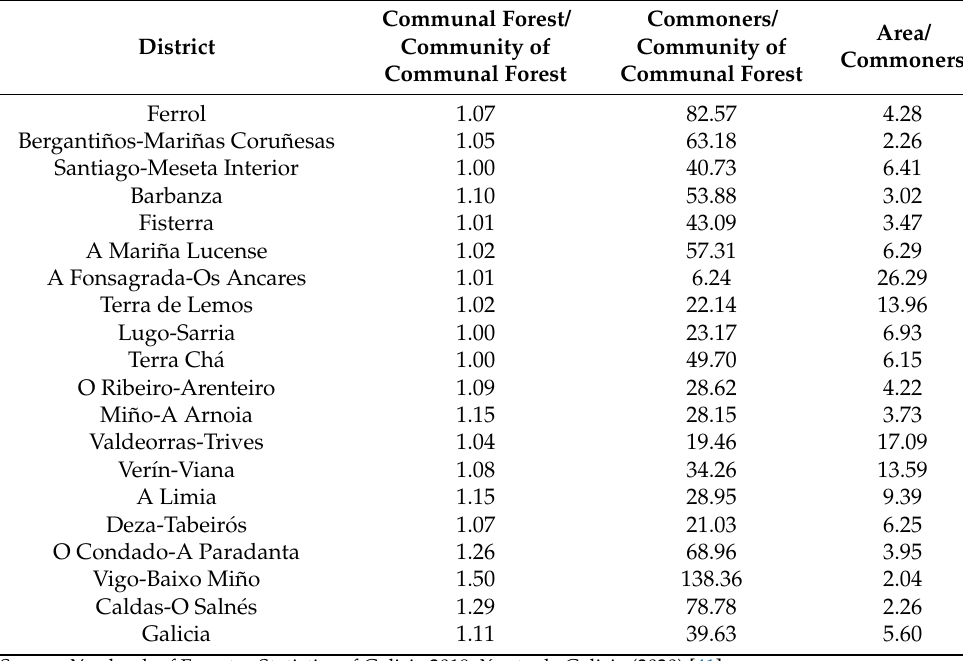
Table 2. Relationships between structures, commoners, and